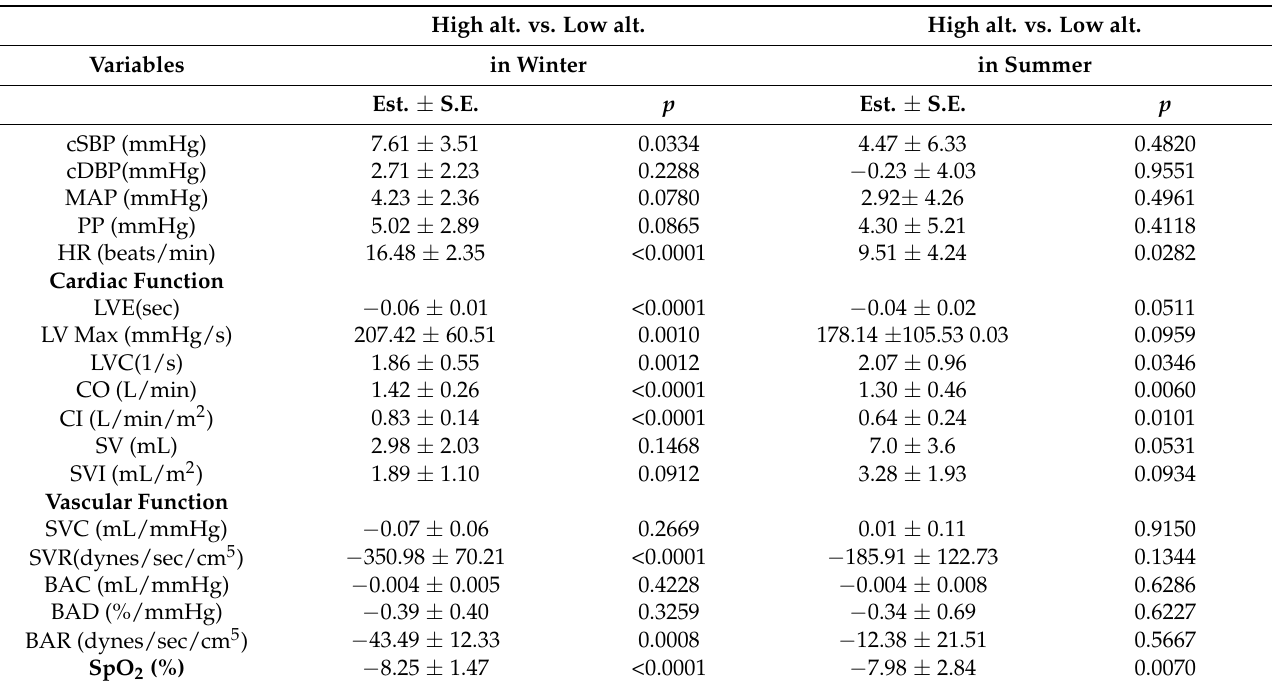
Table 6. Cont. High alt. vs. Low alt. High alt. vs. Low